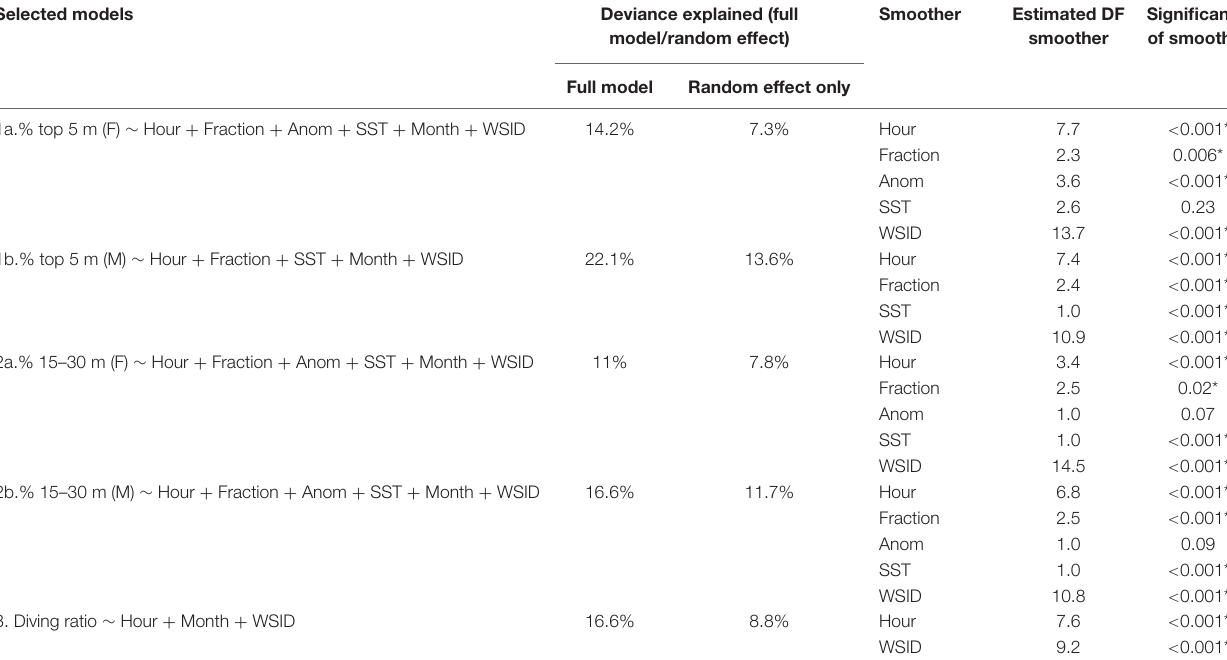
TABLE 2 | Summary of the GAMMs selected by the model selection process (for full set of models included in the model selection process, see Supplementary File A ). Selected